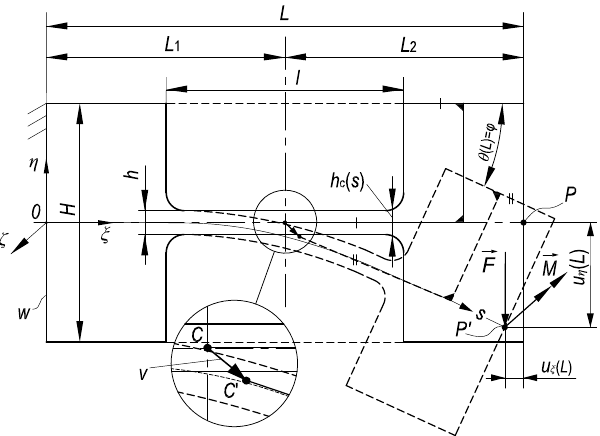
Figure 5. Parameters for the theoretical characterization of a flex- ure hinge (depiction of the initial and deflected position) with the model for the determination of the rotational axis shift based on guiding the center with a constant distance, the fixed center ap-